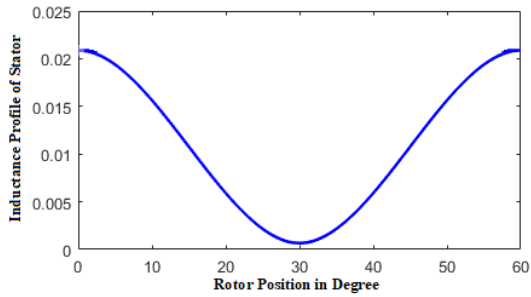
Figure 3. Stator inductance in accordance to rotor position.